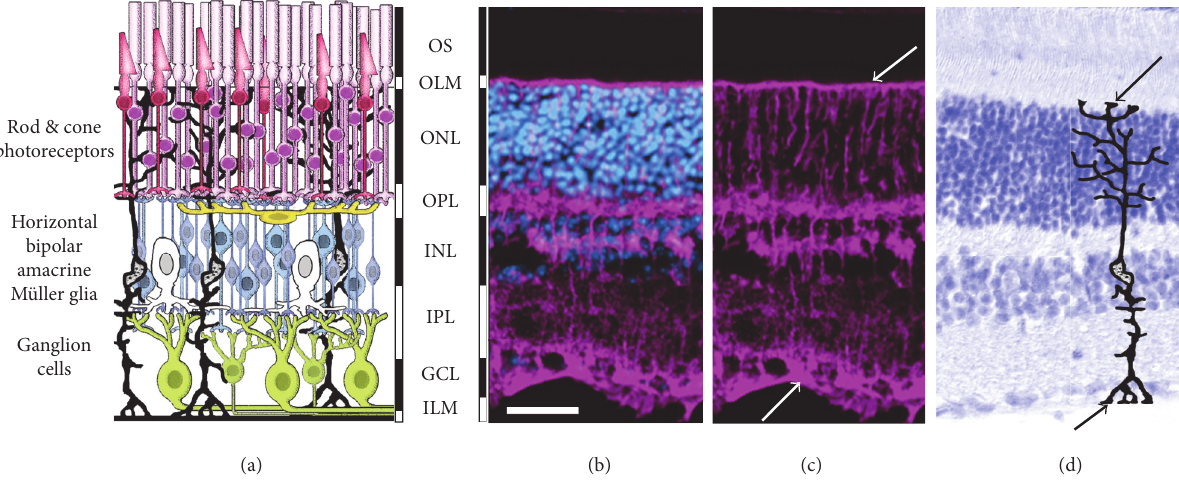
Figure 1: Retinal structure and cellular organization. (a) Diagram shows organization of retinal neurons and M¨uller glia. The cell bodies of rod (purple) and cone (red) photoreceptors are in the outer nuclear layer (ONL) and the photoreceptor outer segments (OS) contain the photopigments that absorb light. Rod and cone bipolar (blue), horizontal (yellow), and amacrine (white) cells are in the inner nuclear layer (INL), with retinal ganglion cells (green) located in the ganglion cell layer (GCL). Between the nuclear layers are the outer and inner plexiform layers (OPL, IPL) containing the synaptic terminals. M¨uller glia (black) have cell bodies located in the INL and extend processes throughout the retina. (ILM, OLM). (b, c, d) Photomicrographs of adult mouse retina. (b, c) M¨uller glia are immunostained for glutamine synthetase (magenta) revealing their radial processes that extend the full thickness of the retina. The M¨uller glial endfeet form the inner limiting membrane (ILM) and outer limiting membrane (OLM) (arrows). (d) Photomicrograph showing histology of adult mouse retina stained with toluidine blue, showing retinal lamina and overlaid with a diagram of a M¨uller glial cell. Arrows indicate glial endfeet at ILM and OLM. Scale bar = 50 microns in (b), (c),